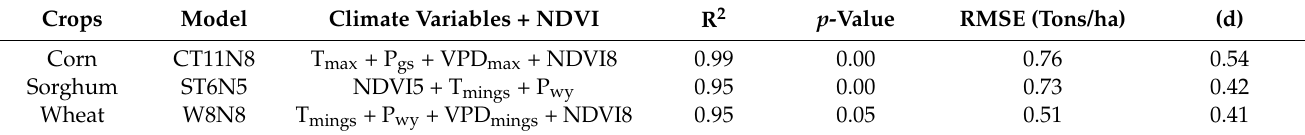
Table 5. Best selected models constructed with climate variables and NDVI